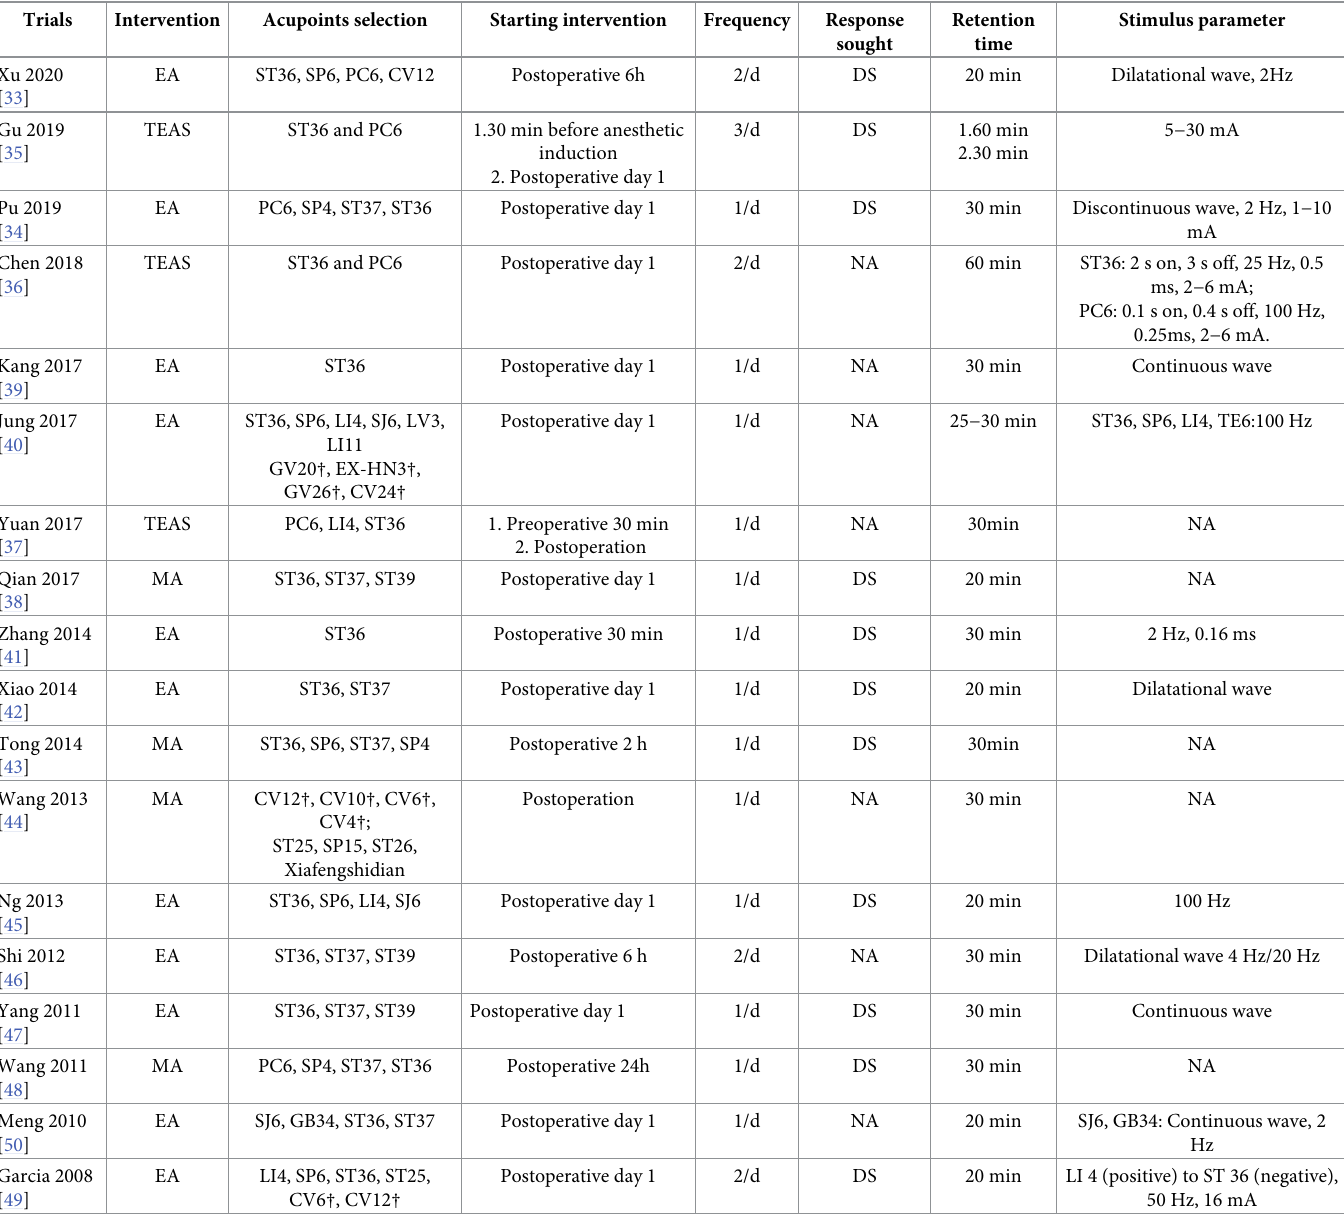
Table 2. Details of